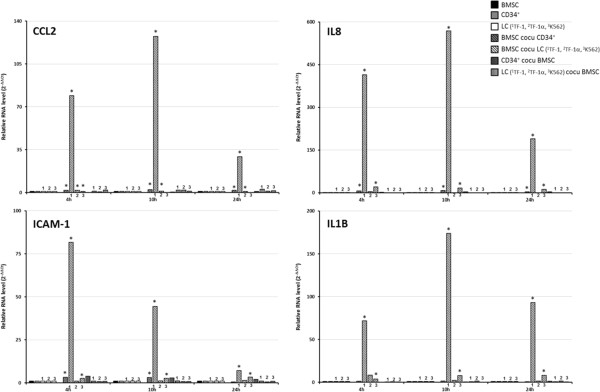
The expression of IL-17 signaling-related genes increase in BMSCs co-cultured with leukemia cells. Quantitative RT-PCR was performed to quantify the expression levels of CCL2, ICAM1, IL8 and IL1B in BMSCs (black column), CD34+ cells (grey bars) and TF-1 (1), TF-1a(2) and K562(3) leukemia cell (LC) (white bars) mono-cultures, BMSCs co-cultured in transwells with leukemia cell lines (black and white stripped column) and BMSCs co-cultured in transwells with CD34+ cells (grey and black stripped column). The RNA levels were shown as 2-ΔΔCt method. Sample key legend is at the top right. * p-value < 0.05